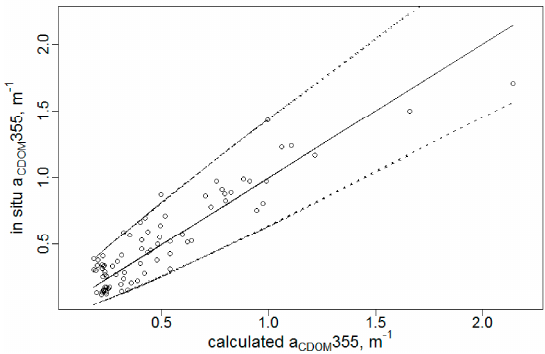
Figure 10. Plot of the in situ a CDOM 355 values versus the a CDOM 355 values calculated according to Model 2. All data are from the validation data set. The solid line corresponds to the one-to-one relationship and the dashed lines are the 95% prediction intervals of Model 2.